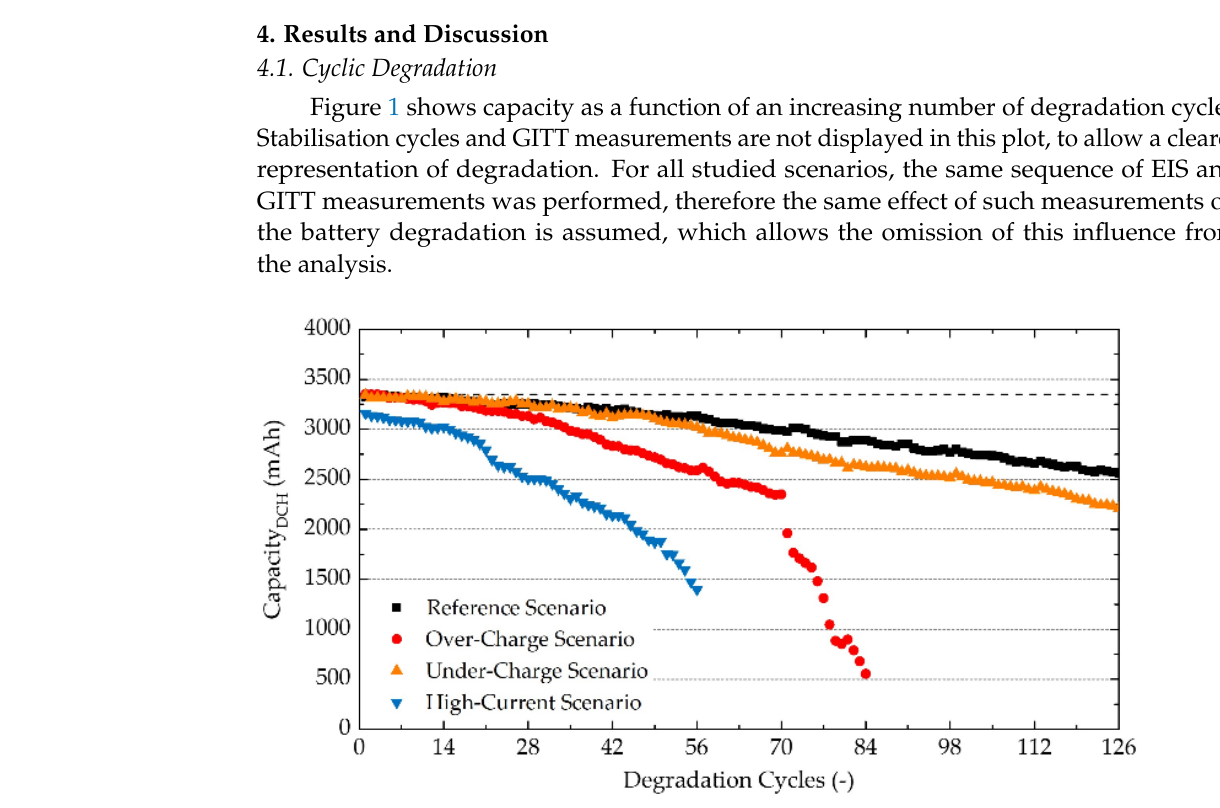
Figure 1. Discharge capacity of the studied NCA 18650B batteries for an increasing number of degradation cycles.